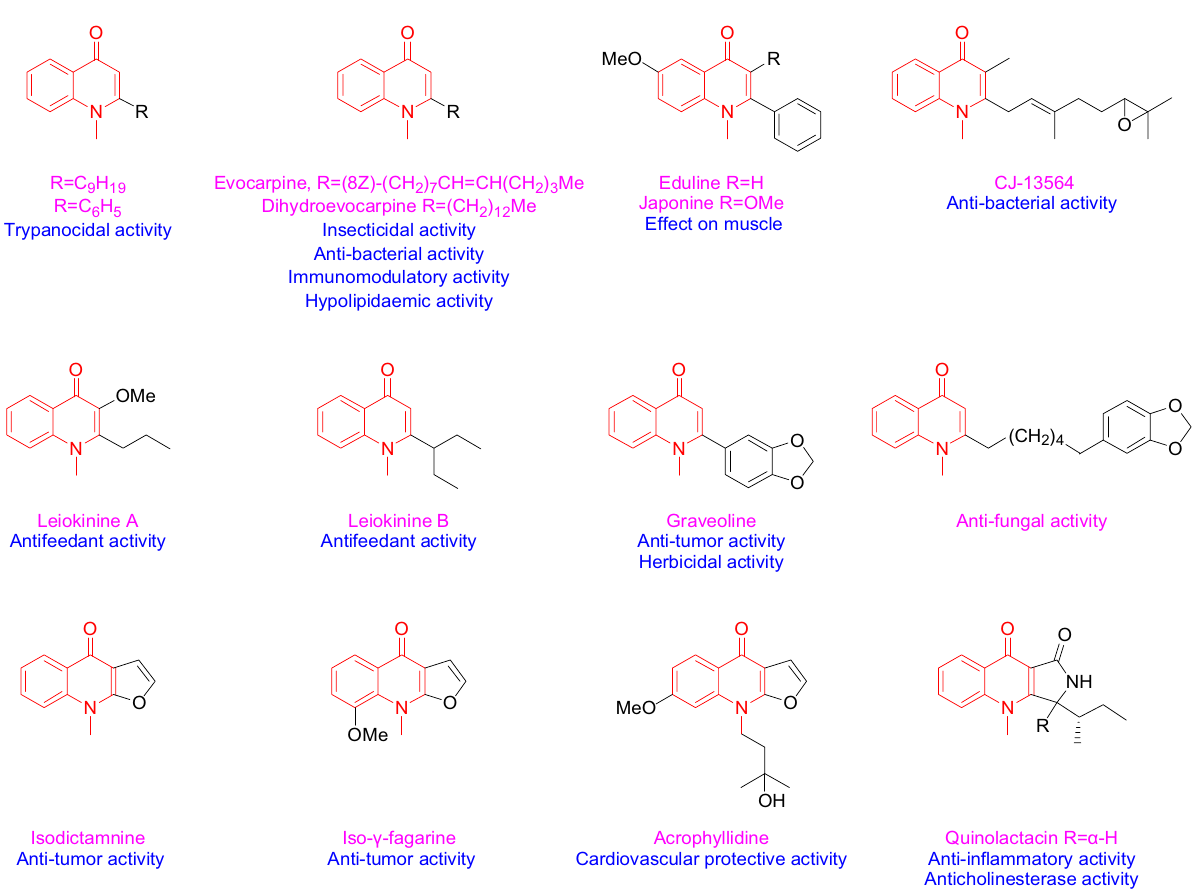
Figure 1. Natural products and drugs containing the core structure of